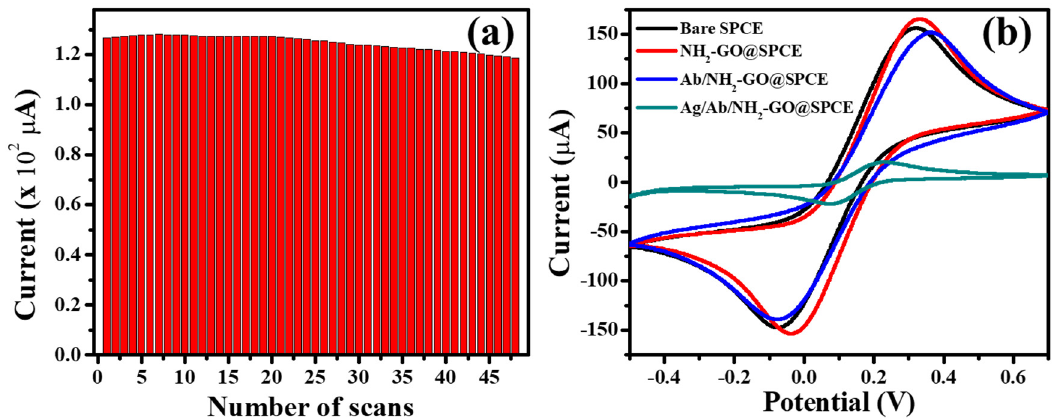
Figure 3. ( a ) Effect of number of scans on stability of NH 2 -GO-modified SPCE. ( b ) Cyclic (CV) response with varying flow rates and Cyclic Voltammogram of sequentially modified electrode Voltammogram (CV) response with varying flow rates and Cyclic Voltammogram of sequentially (Bare SPCE, NH 2 -GO@SPCE, Fer Ab / NH 2 -GO@SPCE, and Fer / Fer Ab / NH 2 -GO@SPCE, respectively) in modified electrode (Bare SPCE, NH 2 -GO@SPCE, Fer Ab/ NH 2 -GO@SPCE, and Fer/Fer Ab /NH 2 -GO@SPCE, bu ff er containing redox marker at a scan rate of 0.04 V · s − 1 respectively) in buffer containing redox marker at a scan rate of 0.04 V·s − 1 .